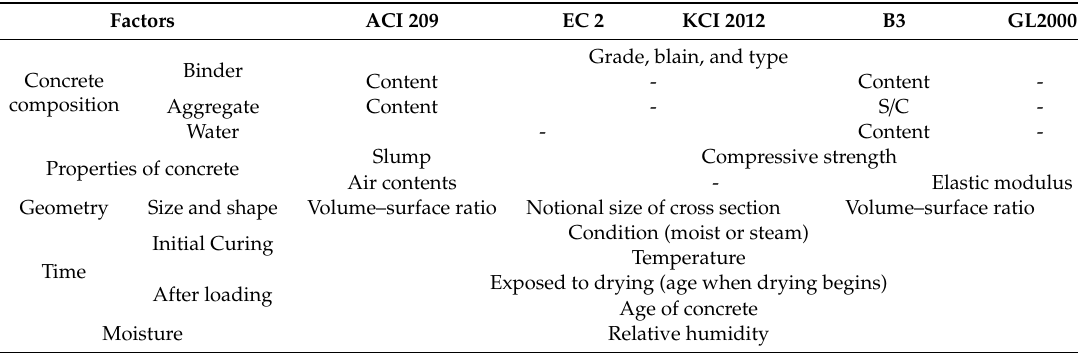
Table 8. Factors of various prediction models for drying shrinkage in